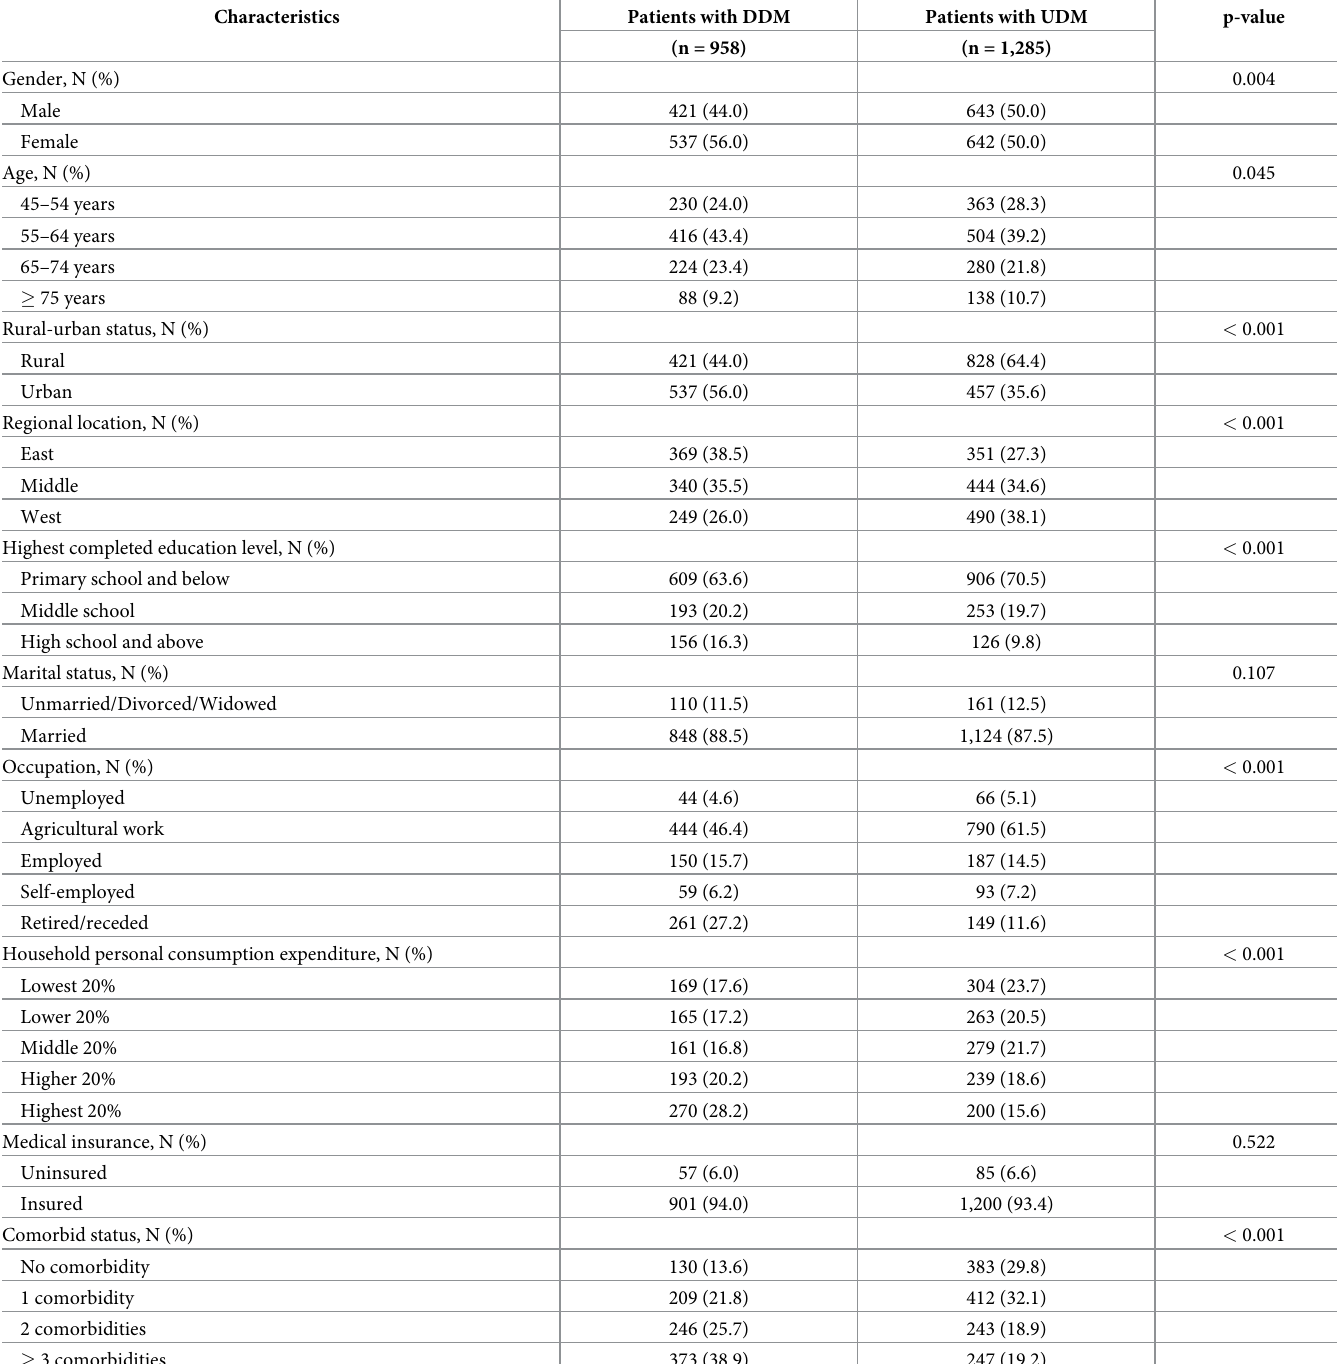
Table 1. Demographic characteristics of the population with DDM and with UDM in the CHARLS 2011 study.